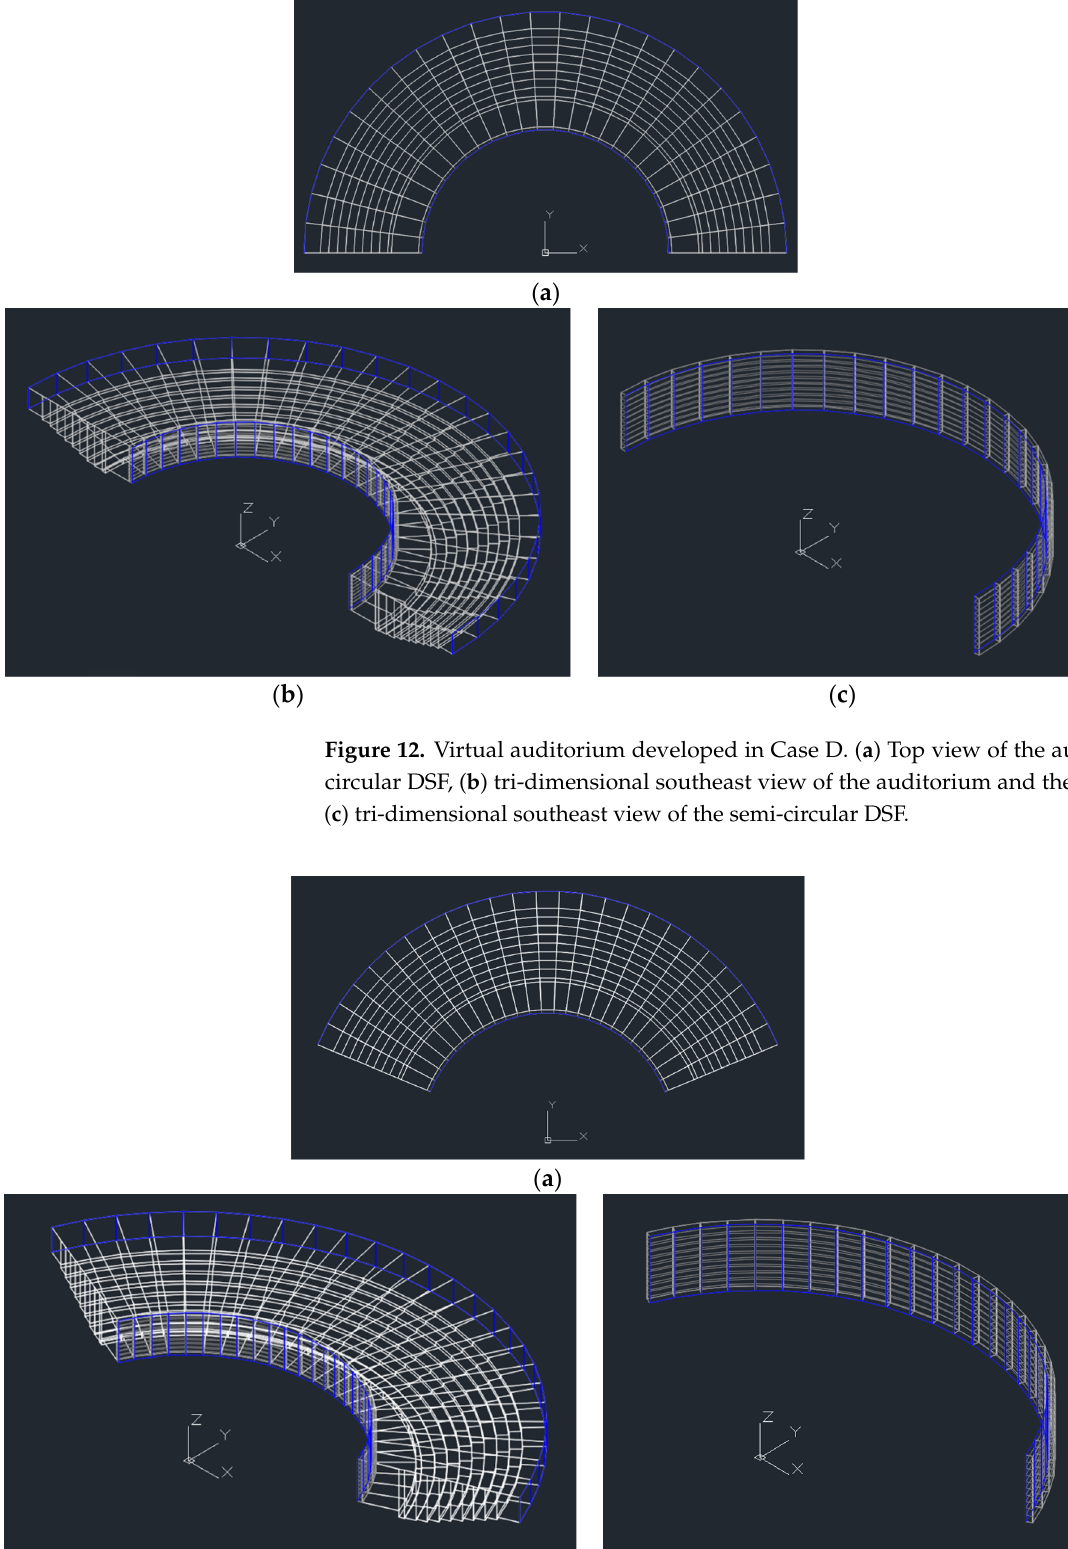
Figure 11. Virtual auditorium developed in Case C. ( a ) Top view of the auditorium and the semi- circular DSF, ( b ) tri-dimensional southeast view of the auditorium and the semi-circular DSF, and ( c ) tri-dimensional southeast view of the semi-circular DSF.